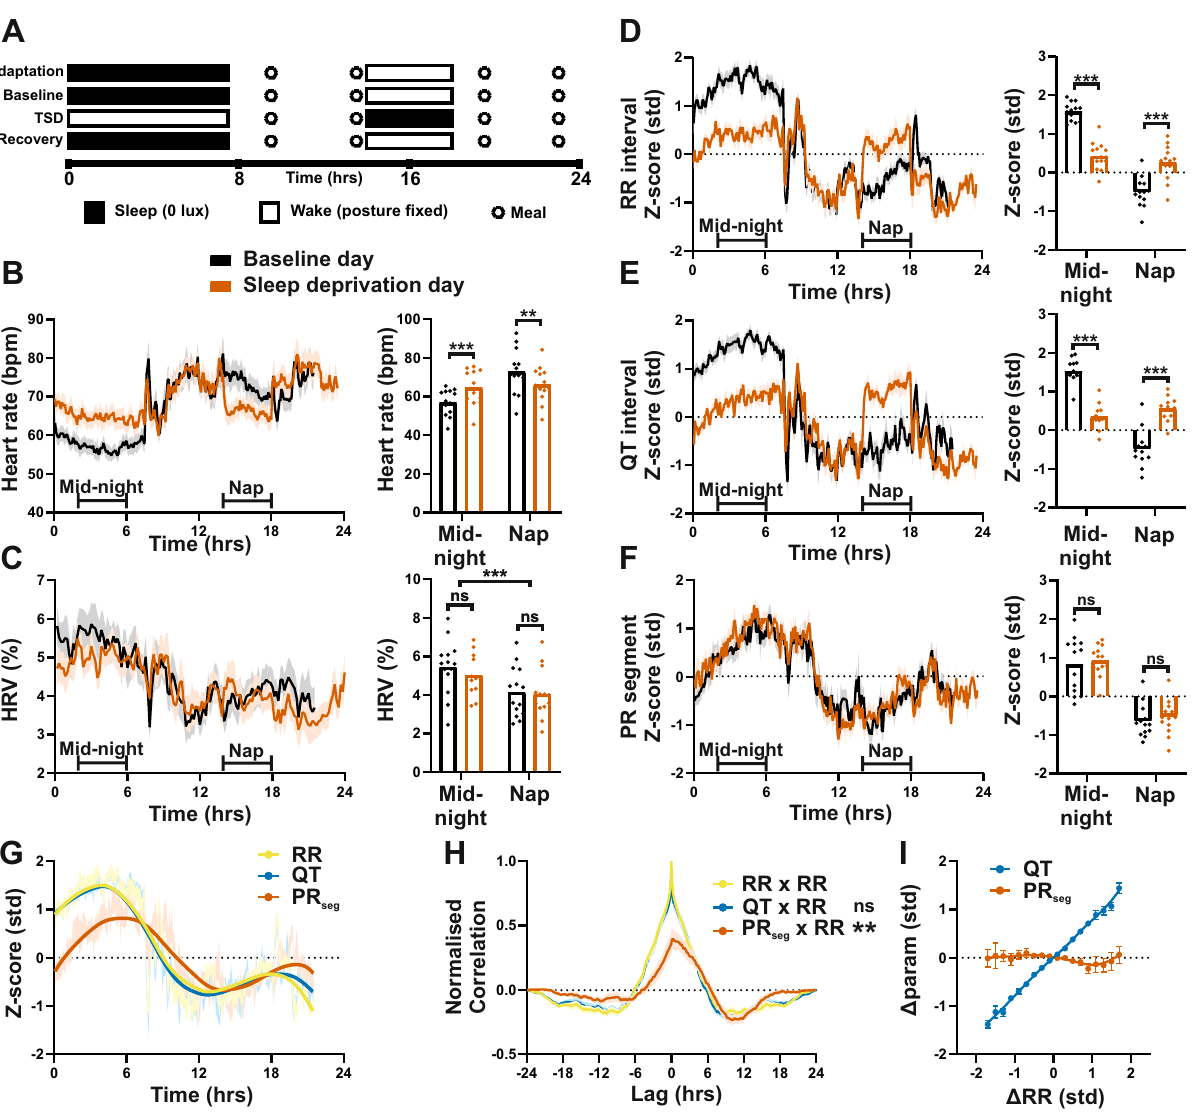
Fig. 1 Longitudinal ECG reveals differential circadian regulation of sinoatrial (SA) and atrioventricular (AV) node function and decoupling by mistimed sleep. A . Schematic of 4-day laboratory session 20 , with total sleep deprivation (TSD) and recovery nap on day 3 ( n = 14 individuals). B – F HR ( B ), HRV ( C ), and z-scored ECG parameter pro fi les under baseline (black) and TSD (orange) days (shading indicates + / − SEM), highlighting the profound impact of mistimed sleep on RR ( D ) and QT ( E ), but not PR seg ( F ). HR has been derived from the RR interval and is shown for clarity. At baseline, all parameters were rhythmic based on cosinor analysis ( P < 0.001). Individual traces were excluded from waveform analysis where data coverage fell <70% of the 5-min time bins; n (baseline/TSD) = 13/14 ( B ), 12/14 ( C ), 13/14 ( D ), 11/12 ( E ), 12/14 ( F ). Mean ECG parameters were quanti fi ed across a 4 h mid-night and mid-day (equivalent to the nap window on day 3) analysis windows on the baseline and TSD days (two-way RM ANOVA/Mixed model; n = 14 ( B , C , D , F ), 12 ( E )). G , H Under baseline conditions, LOWESS fi t of ECG pro fi les ( G ) and cross-correlation ( H ; yellow: RR vs RR, blue: QT vs RR, orange: PR seg vs RR) revealed a signi fi cant phase delay in PR seg rhythm relative to that of RR (Gaussian fi t with one-sample T test; n = 13, 11, 12, respectively). I Acute changes in RR were mirrored by a concordant change in QT, but not PR seg duration ( Δ RR re fl ects z-scored difference in RR between sequential 5-min analysis bins; Δ param re fl ects the concurrent change in QT or PR). All data presented as group mean ± SEM; ns P > 0.05, ** P < 0.01, *** P < 0.001. bpm = beats per minute; std = standard deviation. See Supplementary Fig. S2 for additional information; source data and statistical details are provided as a Source Data File. no sleep) to reveal circadian clock-controlled processes. Indeed, newly imposed schedule. By contrast, the daily rhythm in PR seg did not adapt to the night-shift routine throughout the study RR, QT, and PR seg parameters exhibited circadian rhythmicity (Fig. 2C). This lack of rapid adaptation in the PR seg rhythm is under constant routine in both day- and night-shift groups consistent with slow circadian re-entrainment after an abrupt (Fig. 2D – F). Rhythms in RR, QT, and PR seg exhibited a similar phase (i.e., time of peak interval duration) between day- and behavioral phase shift. Immediately following the 4-day-shift night-shift groups when aligned to external clock time (but not routine, all participants were placed under a constant routine when aligned to time awake). This suggests that the circadian protocol — a gold-standard procedure that removes or holds mechanism that underpins ECG rhythmicity is robust against acute change in behavioral patterns, and opposes the more direct in fl uence of activity and sleep state on cardiac electrophysiology. behavioral rhythms (through constant semi-recumbent posture, NATURE COMMUNICATIONS| (2021)